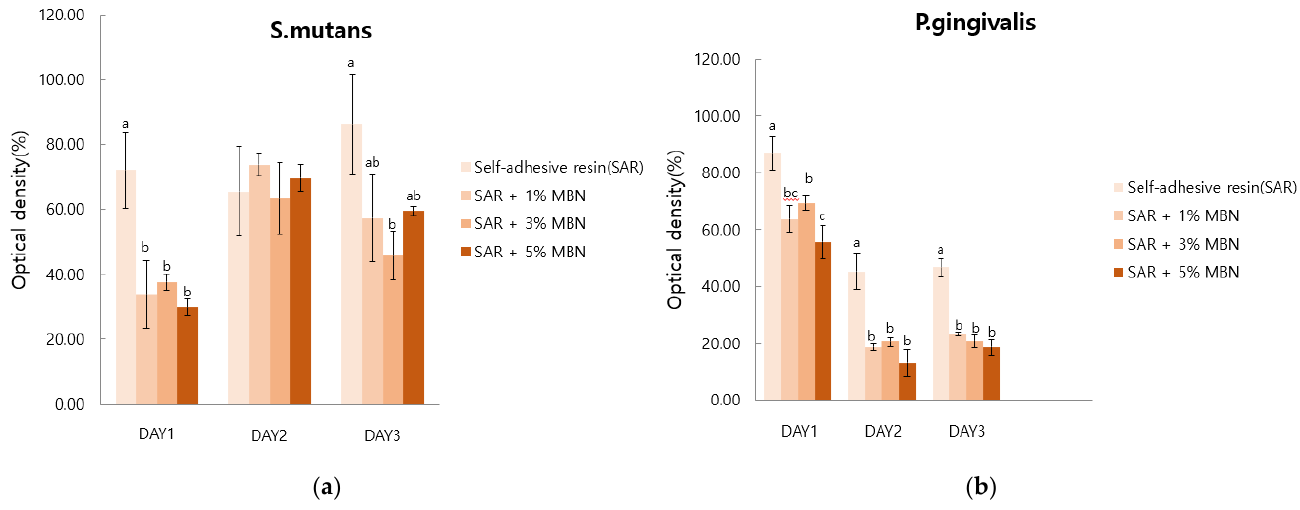
Figure 7. Anti-bacterial effect test of the control (SAR) and MBN-incorporated SAR groups. Labels with the same letters indicate no statistically significant difference between the groups. One-way ANOVA was performed ( n = 3). ( a ) S. mutans , ( b ) P. gingivalis